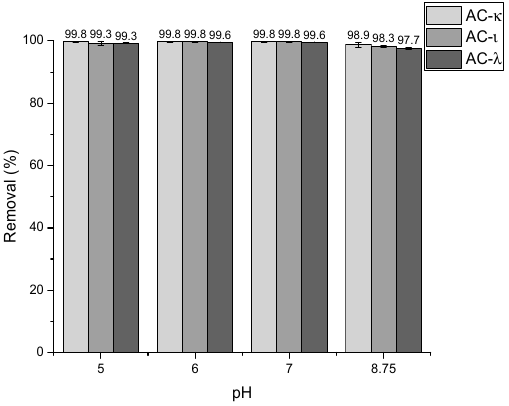
Figure 7. Removal of ciprofloxacin (50 mg/L) from water samples at distinct pH using the activated carbons (conditions: 24 h contact time, sorbent dosage: 0.5 mg/mL).